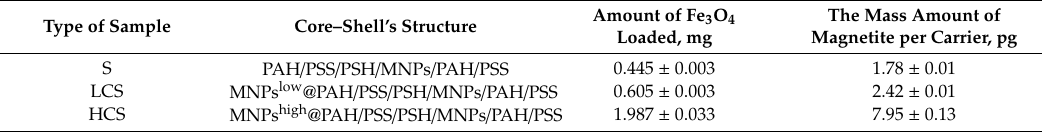
Table 1. Amount of magnetite nanoparticles loading into submicron core–shells data.